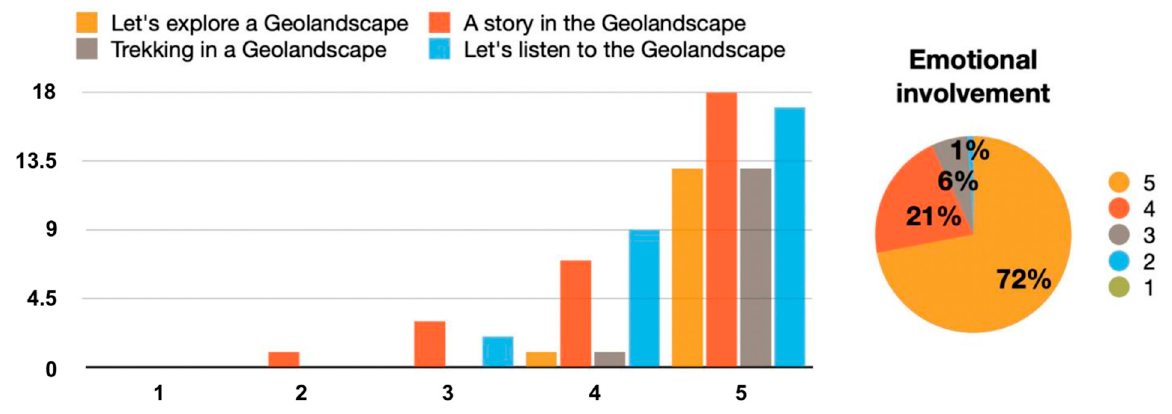
Figure 10. Emotional involvement of participants in Paesaggeo ’s excursions; the x -axis indicates the level of emotional involvement; the y -axis shows the number of responses.